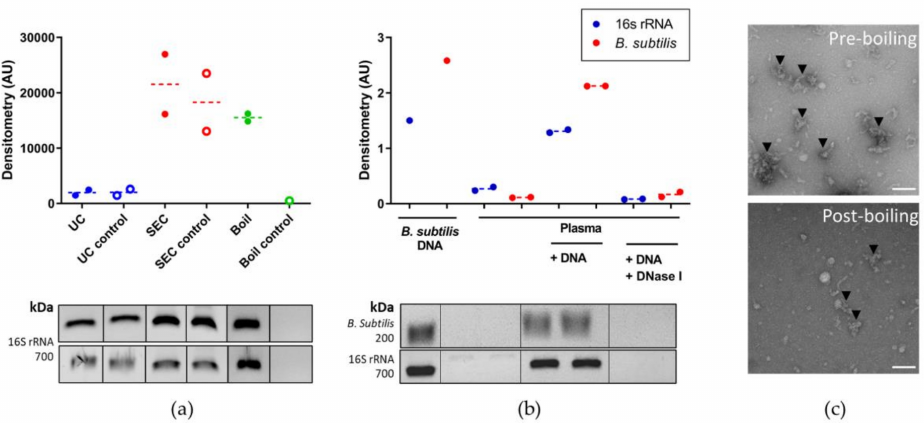
Figure 3. Optimisation of plasma-derived BEV DNA isolation. ( a ) EV isolation protocol comparison and densitometry of the corresponding PCR products per mL of plasma (AU). Ultracentrifugation (UC; blue), size exclusion chromatography using qEV columns (SEC; red) and boiling (boil; green). SEC and boiling methods show higher 16S rRNA gene amplification than ultracentrifugation. Only the boiling method identified significantly lower 16S rRNA gene amplification in the protocol control (water). The boiling method was identified as the optimal protocol for isolating BEVs for DNA extraction and was used for the main 16S rRNA gene sequencing analysis. Sample n = 1–2. The error bars represent the standard deviation (SD). ( b ) Extracellular DNA was eliminated from plasma samples by pre-treatment with DNase I. Chromosomal DNA from B. subtilis was used to spike plasma samples prior to DNase treatment to confirm the effectiveness of extracellular DNA removal (non-lysed samples). Plasma samples were processed for DNA extraction and amplified using primers specific for both B. subtilis (red) and the V3–V4 region of the 16S rRNA gene (blue). DNA was amplified by both primer sets ( B. subtilis DNA), which was subsequently eliminated by DNase I treatment (plasma + DNA + DNase I) but not when DNase I was excluded from the reaction (plasma + DNA). Sample n = 1, analysed in duplicate except for B. subtilis DNA positive control. The error bars represent the standard deviation (SD). A faint 16S rRNA band corresponding to extracellular DNA was detected in the plasma control sample (*) which was eliminated by DNase I pre-treatment. ( c ) TEM imaging confirmed the reduction in extracellular protein aggregates (black arrowheads) after boiling. Scale bar 200